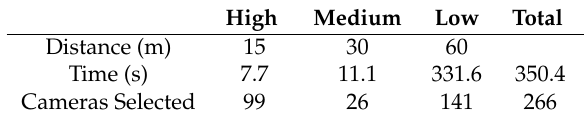
Table 3. The number of cameras and the computational timing results for each of the optimized